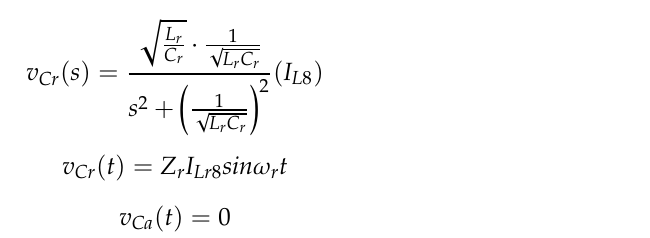
Figure 11. The equivalent circuit of Mode 8 and key waveform.